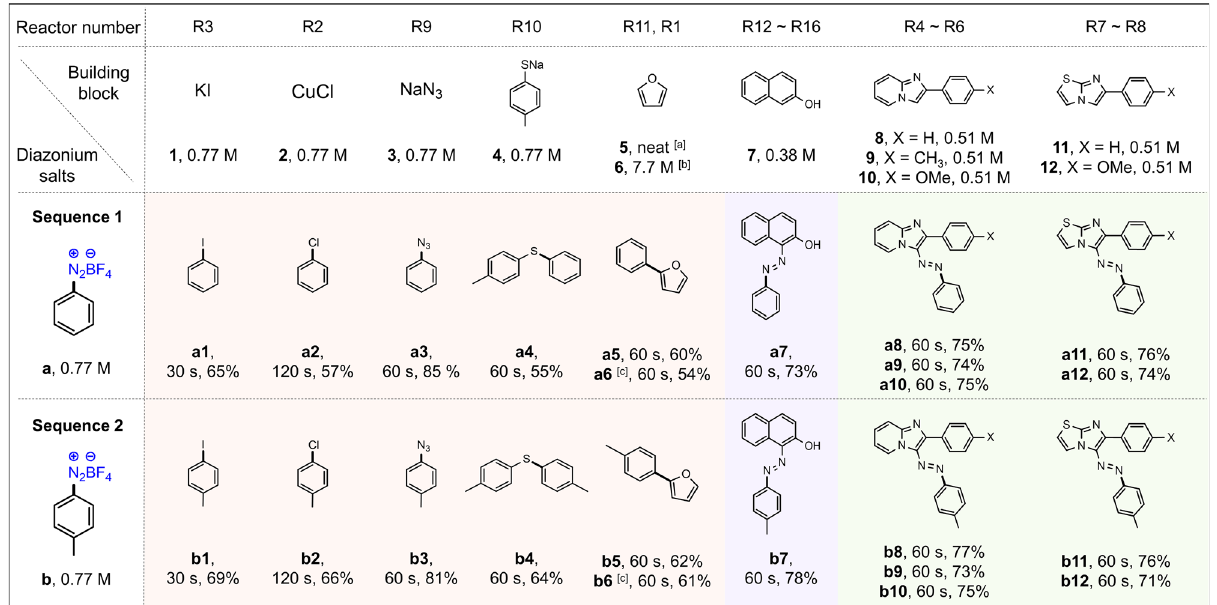
Fig. 6 Summary for optimized reaction conditions and yields for 24 parallel reactions. All reactions were carried out at room temperature. The yield was calculated from isolated product. a 4-Aminomorpholine (5 mol%) was premixed with building block solution. b Eosin-Y (5 mol%) was premixed with building block solution. c 530 nm green LED was used. The red boxed region represents the syntheses based on substitution of nucleophilic aromatics, the purple boxed region represents azo-coupling of carbocycles, and the green boxed region represents azo-coupling of